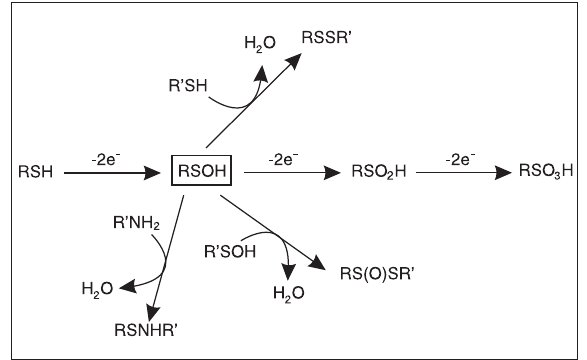
Figure 2. Formation and reactions of sulfenic acid. Thiol